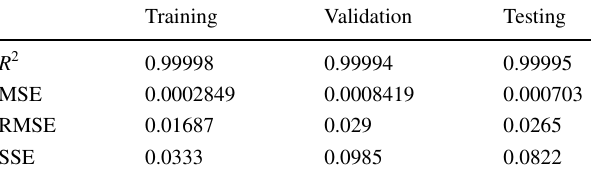
Table 7 Summary of ANN model